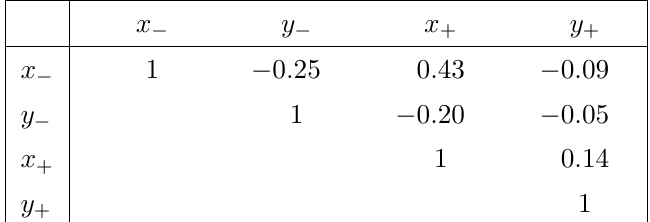
Table 4 . Correlation matrix of the experimental and strong-phase related systematic uncertainties.